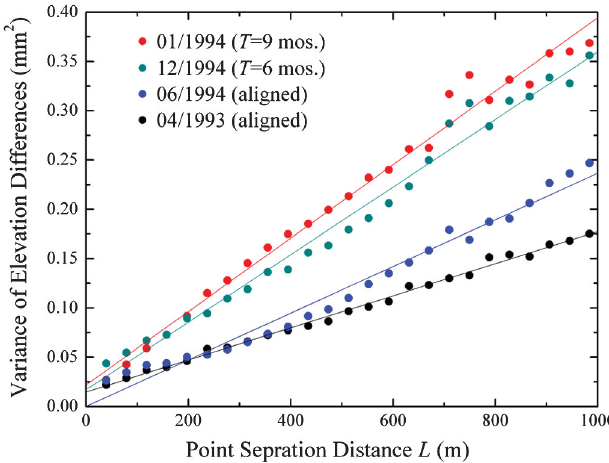
FIG. 14. (Color) The variance of relative displacement of the CERN LEP magnets vs the distance between them L (from Ref.